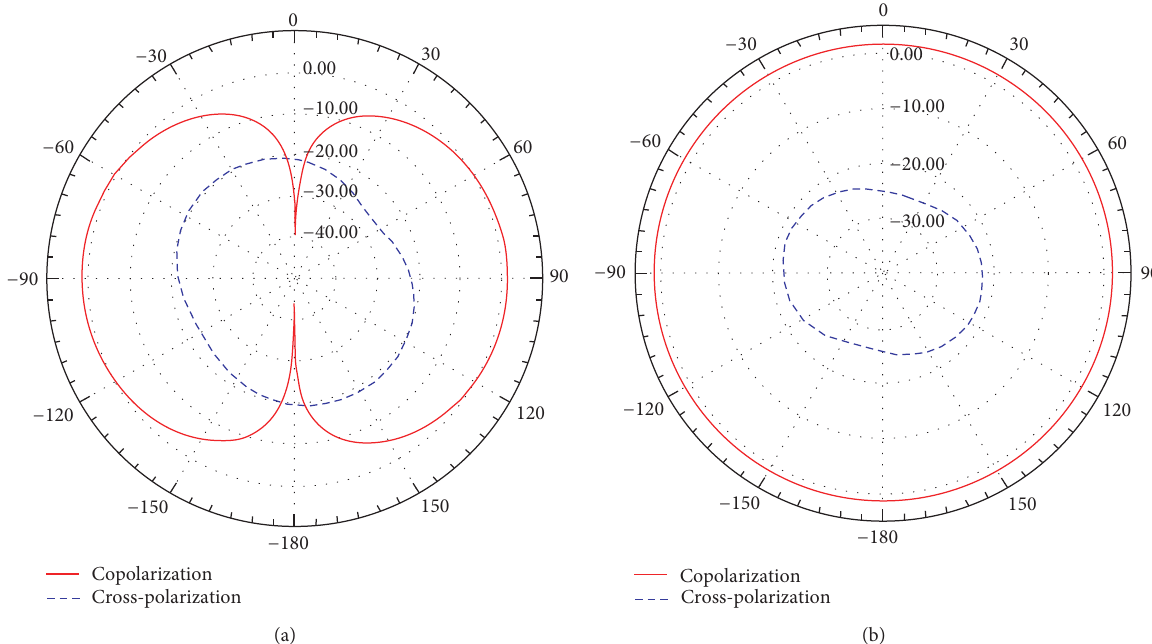
Figure 5: Measured radiation patterns of the proposed antenna at 433 MHz (a) E -plane (i.e, XZ plane) and (b) H -plane (i.e., YZ plane).